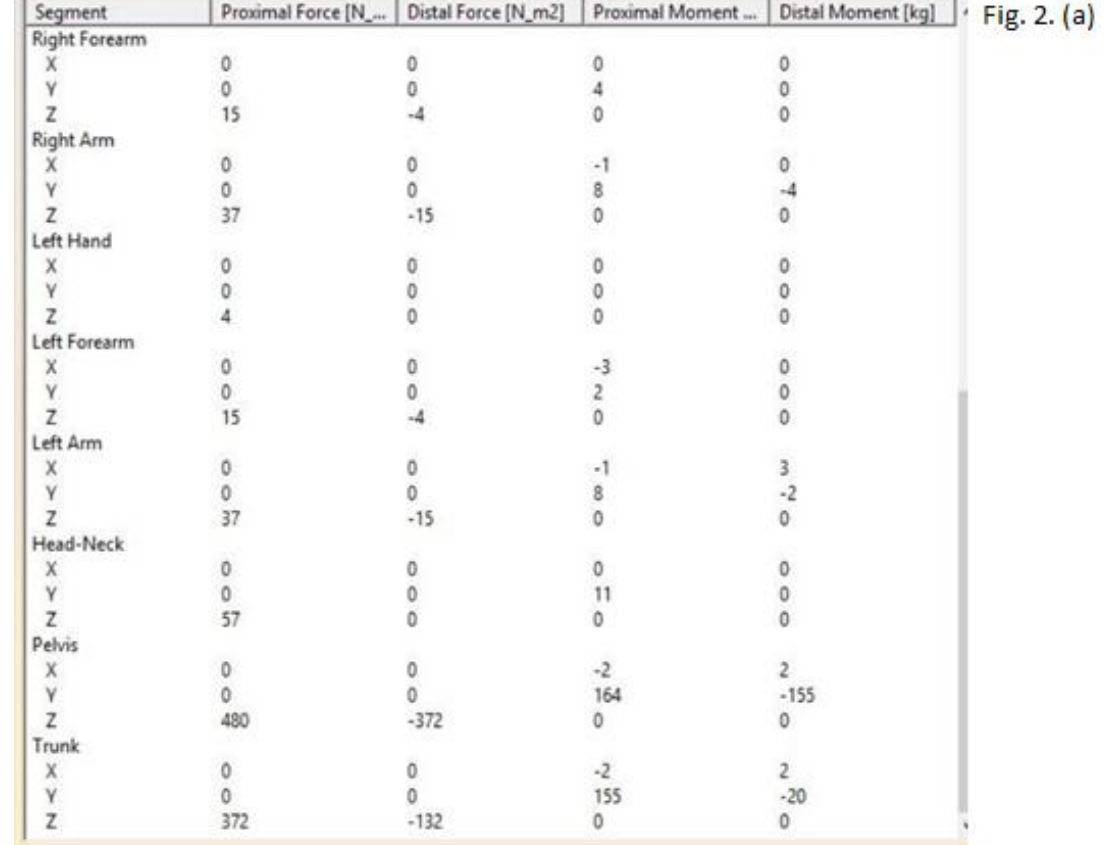
Figure 1. CATIA computer model and typical body position of the